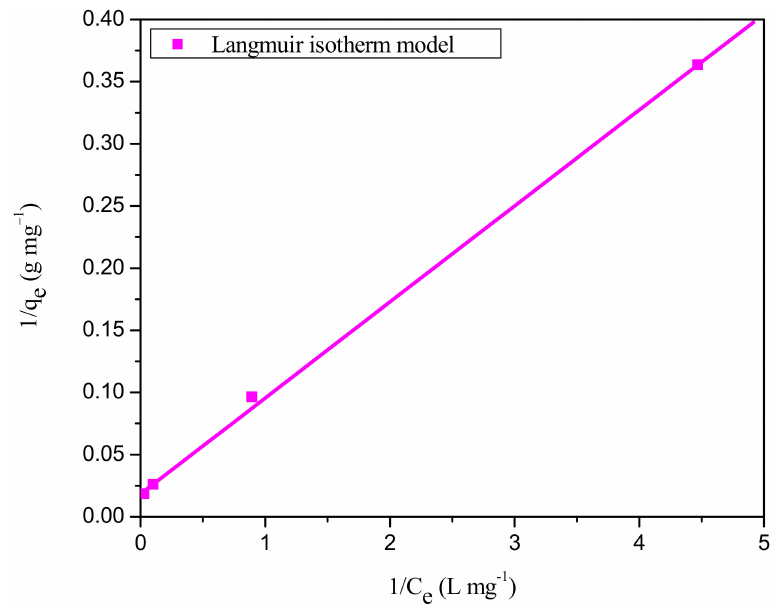
Figure 10. Langmuir isotherm plot for adsorption of RBBR dye onto WSBAC adsorbent. (Initial pH: 2;